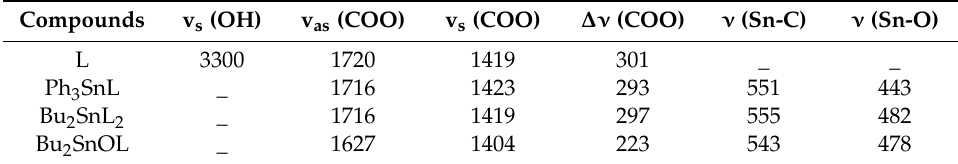
Table 2. Ligand and complexes FTIR spectra data.